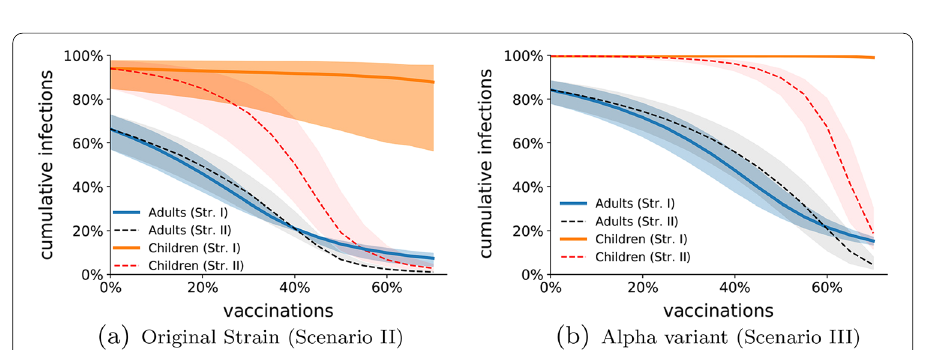
Fig. 5 Effect of children vaccination. We show the Monte Carlo estimation (over 100 independent simulations) of the cumulative fraction of infections among non-vaccinated adults (blue) and children (orange) at the end of the pandemic outbreak, as a function of the fraction of vaccinated population V . The solid curves refer to Vaccination strategy I, in which only adults are eligible for vaccination; the dashed curve refers to Vaccination strategy II, in which vaccine shots are randomly assigned to the entire population. In ( a ), we consider the original strain; the vertical bands represent the confidence interval with respect to the decreased infectiousness of children. In ( b ), we consider the Alpha variant; the vertical bands represent the confidence interval with respect to the increased infectiousness of the Alpha variant. The parameters used in the simulations are listed in Table 2, q a = 0.25 , and q c =